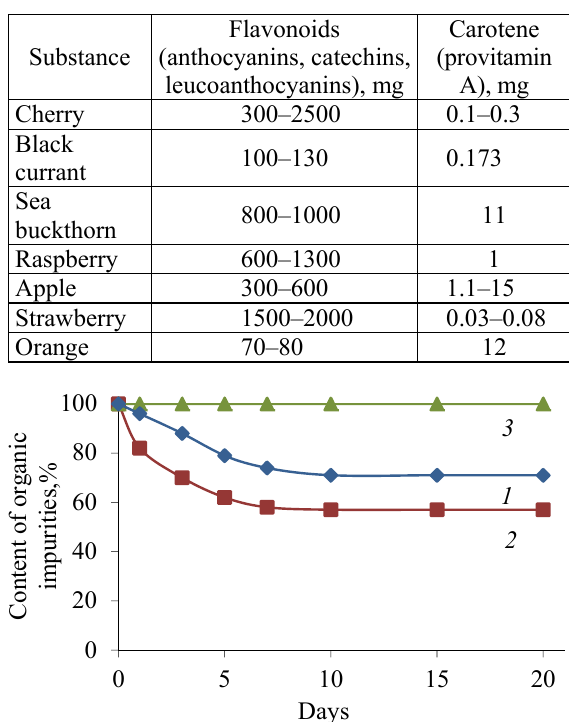
Table 4. Content of the components that impart color